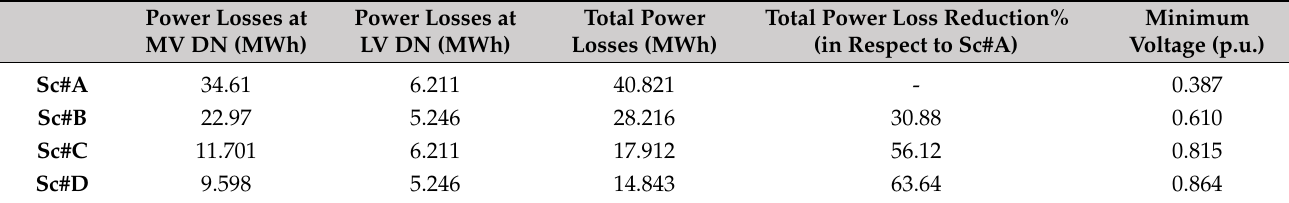
Table 5. Results of the proposed methodology.